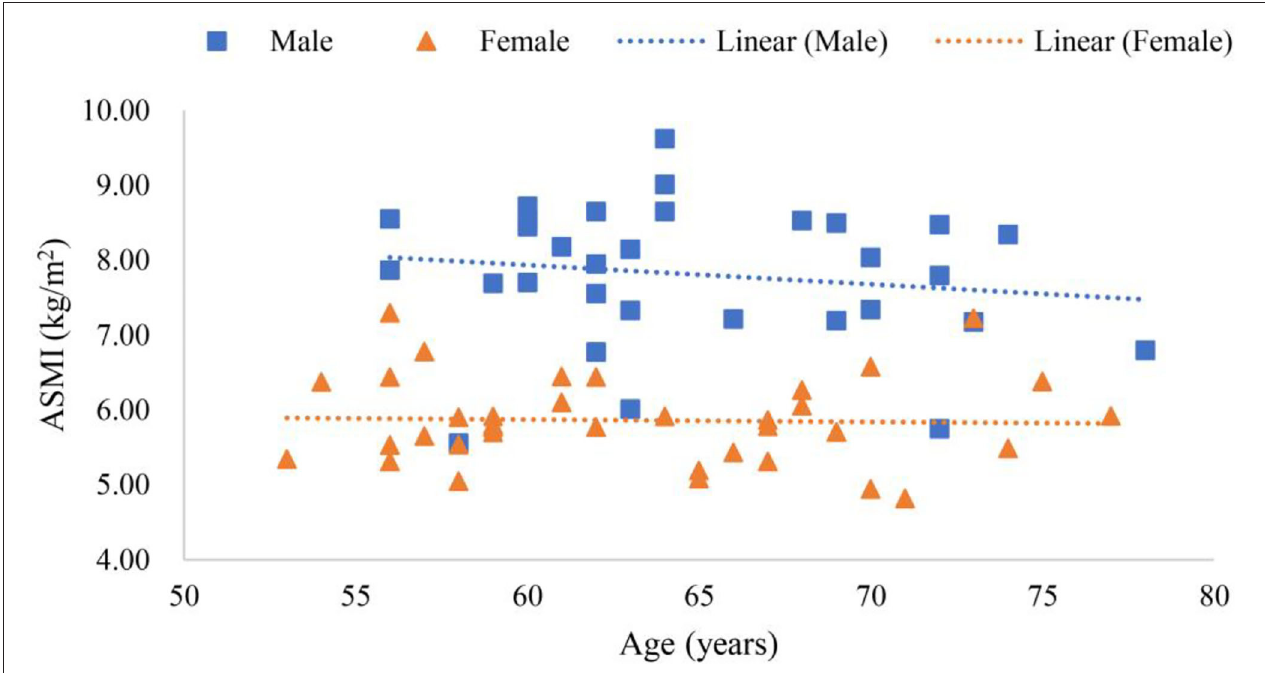
FIGURE 3 | Scatter plots of participants’ age and appendicular lean mass index (ALMI).